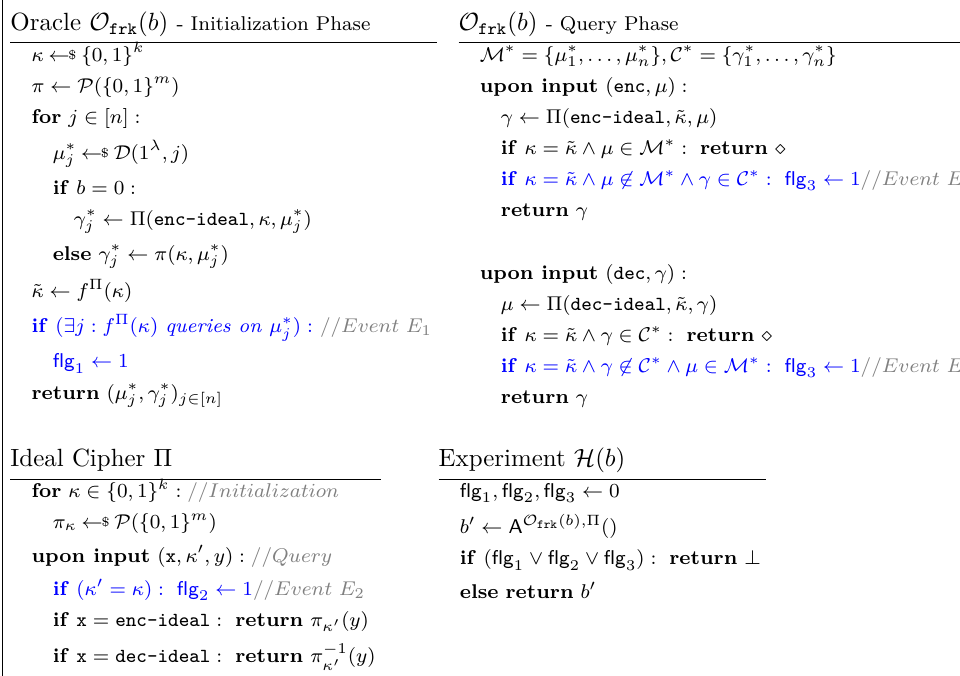
Figure 2: The hybrid experiment H ( b ) and the corresponding modified oracles. The differences in the oracles between the original security experiment in Definition 5 and the hybrid experiment are highlighted in